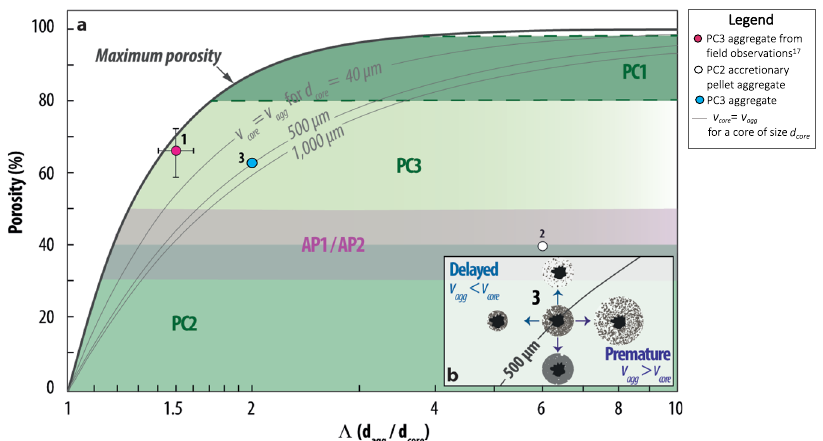
Fig. 3 Aggregate types and rafting. Generalized plot showing the potential for particle rafting for different types of aggregates. a Green zones indicate observed values of porosity ( ϕ A ) for PC1 18,19 , PC2 19 and PC3 17,19 , while the pink area indicates the typical values of porosity for AP1 and AP2 18,43 (see also table 16.1 in Sparks et al. 1997 44 ). Unfortunately, the few studies present in literature for PC1 do not allow a good constraint on the values of the associated porosities (indicated, therefore, as dashed lines). Aggregates 1 and 2 represent a PC3 from Sakurajima 2013 Vulcanian eruption 17 and a well-structured accretionary pellet (AP2) from the 26 December 1997 dome collapse of Soufrière Hills volcano, Montserrat, respectively; 21 aggregate 3 represents a generic PC3 with core size of 500 μ m (with characteristics observed during the 2013 Sakurajima eruption 17 ). The errorbar associated with aggregate 1 represents the 68% of uncertainty on Λ and ϕ A respectively. b ) A zoom around aggregate 3 to show the in fl uence of aggregate porosity on premature and delayed sedimentation of the core; in all cases the particles of the shell are prematurely sedimented. The premature sedimentation of the coating ash can be seen considering each single particle as a fi ctitious core characterized by large values of Λ ( Λ ≫ 10): Fig. 3 shows that ash characterized by Λ ≫ 10 and size d P ≲ 100 μ m is not subjected to rafting.